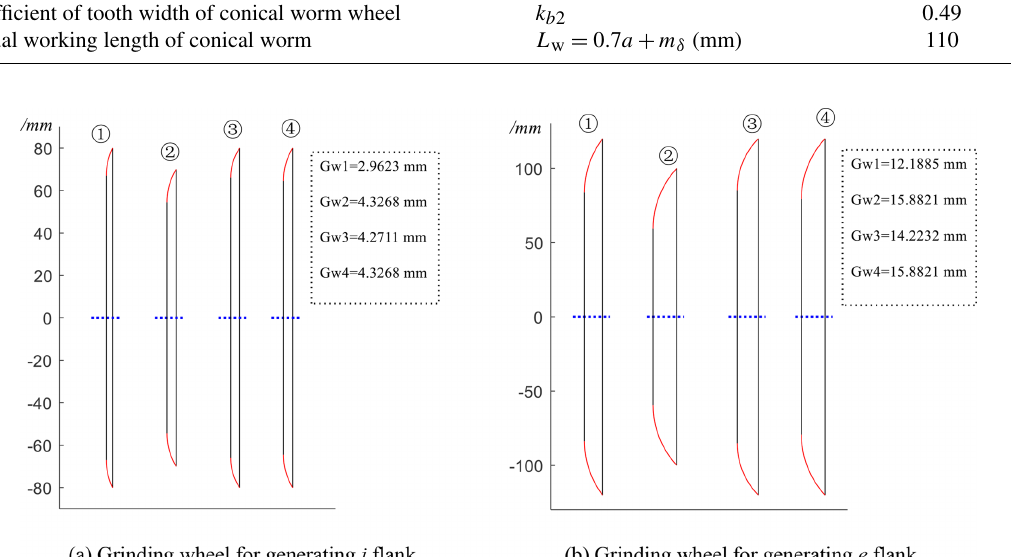
Figure 4. Grinding wheel in the shaft